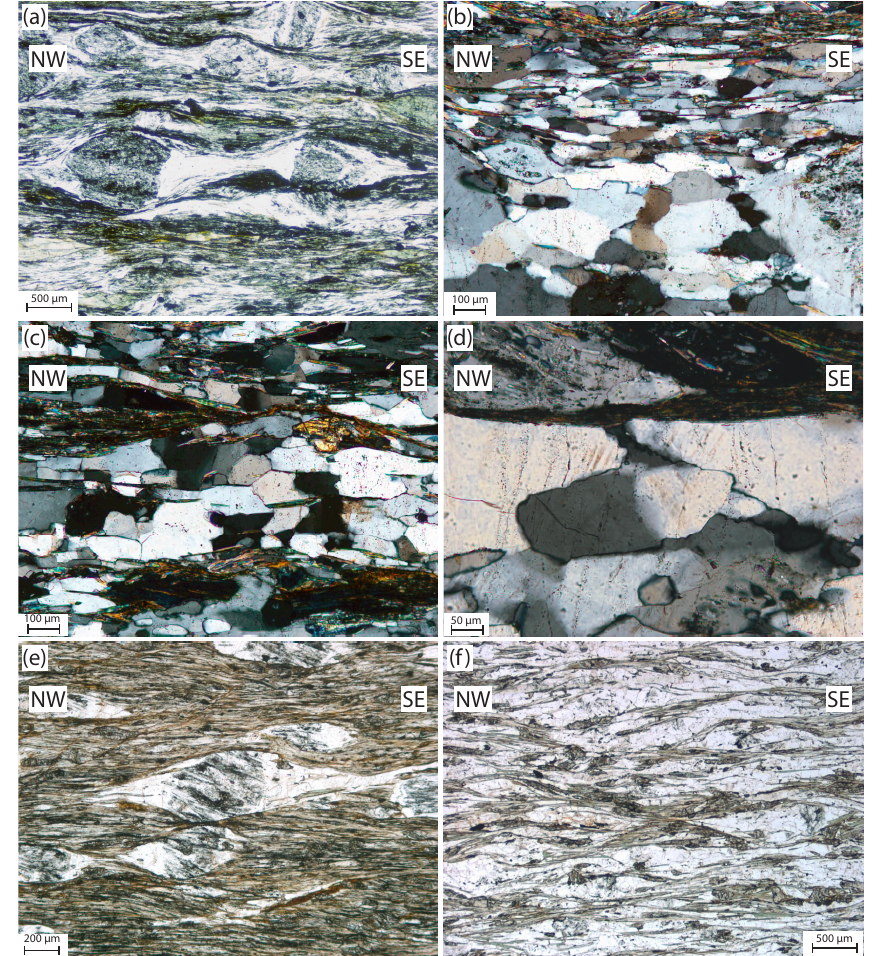
Figure 5. S2 fabric in metagreywacke. Sample locations are shown in Fig. 2a and listed in Table S1. (a) Quartz filled between two pulled-apart ablite porphyroblasts in the center of the image. Sample PS107. (b) Quartz precipitated in the pressure shadows between albite porphyrob- lasts. Sample PS185. (c) Q domain in Sample PS190. (d) Undulose extinction and bulging in quartz grains precipitated in pressure shadows in Sample PS185. (e) Shear bands and asymmetric albite porphyroblast tails show a top-to-NW sense of shear. Sample PS185. (f) Conjugate shear bands outlined by white mica and chlorite in Sample